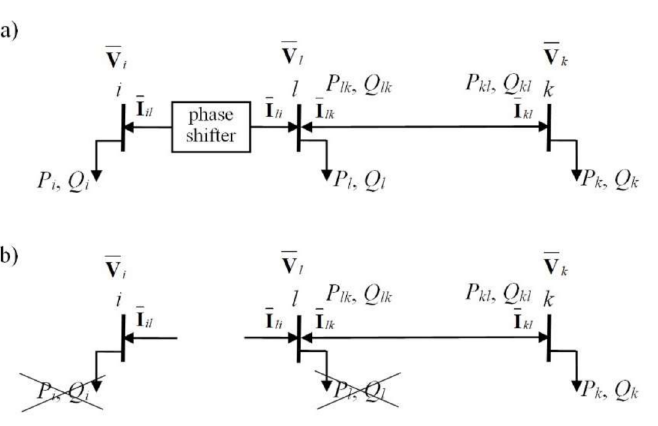
Figure 5. A fragment of the power system model with the quadrature booster used in Method 1 ( a ) and the corresponding fragment of the power system model with the switching off of the quadrature booster used in Method 2 ( b